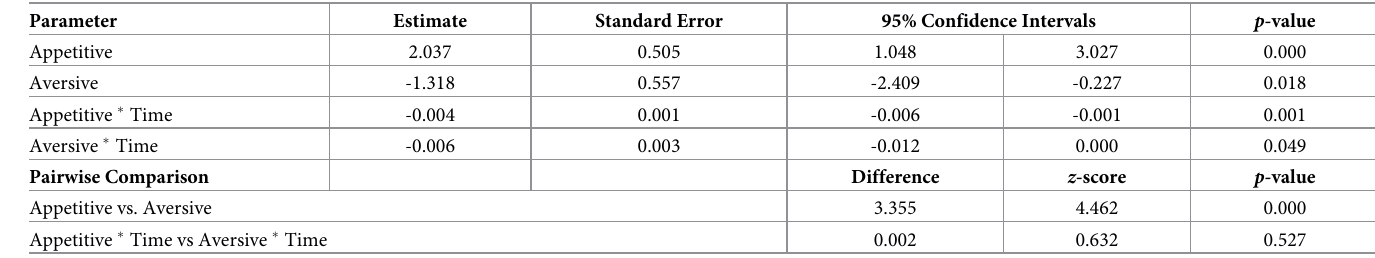
Table 8. Experiment 2 preference MPR